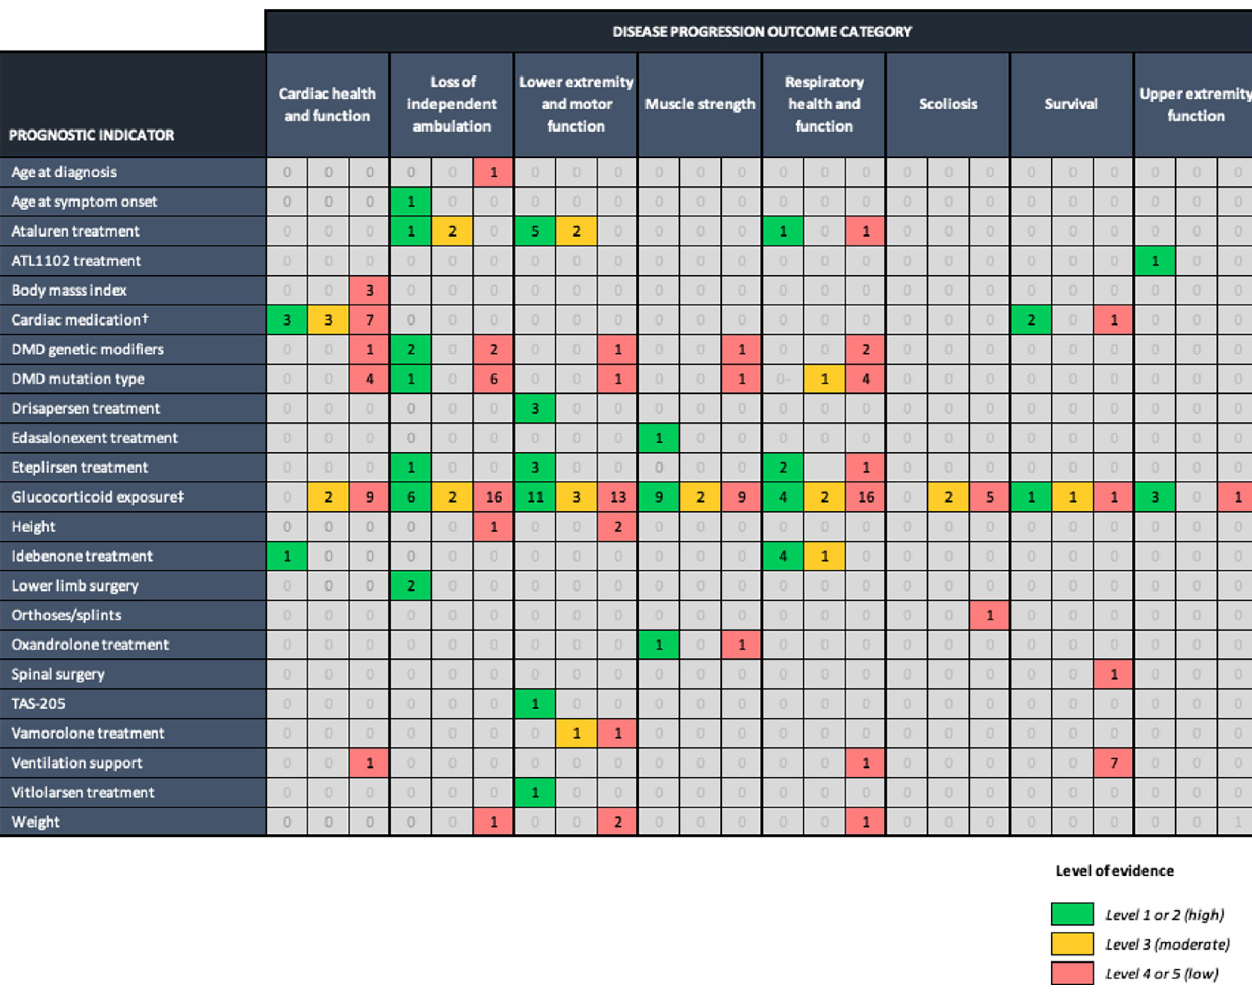
Fig 2. Evidence of prognostic indicators of disease progression in DMD. Note: Numbers shown in the coloured squares refer to the number of studies reporting of the specific indicator. † Angiotensin-converting enzyme (ACE) inhibitors, beta blockers, and/or diuretics. ‡ Age at treatment initiation, dose, duration of exposure, pharmacological agent, and regimen. Duchenne muscular dystrophy (DMD).